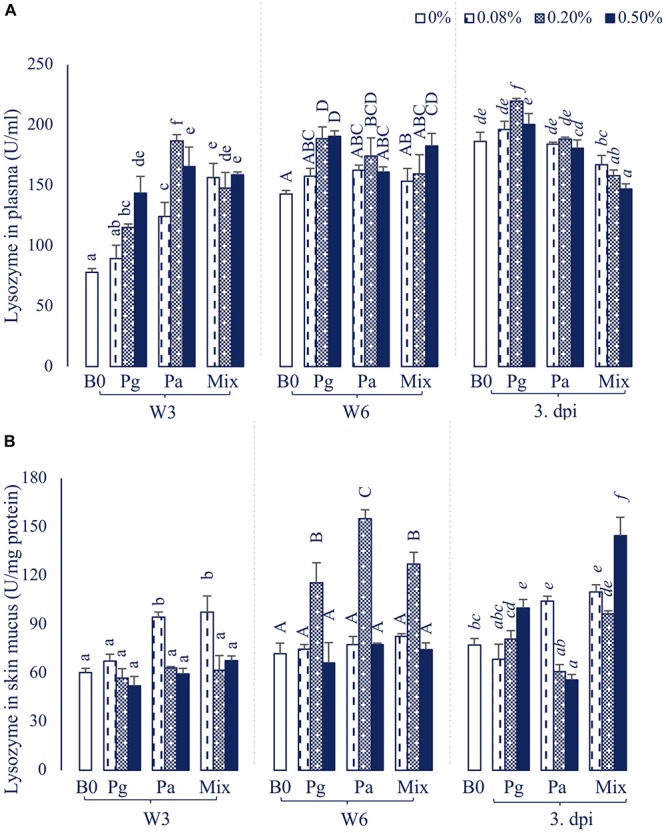
Lysozyme activity in (A) plasma and (B) skin mucus of striped catfish fed extract-based diets supplemented with a single supply or a mixture of P. guajava and P. amarus at 0; 0.08; 0.2; and 0.5% after 3, 6 weeks and 3 dpi. B0, basal diet; Pg, P. guajava; Pa, P. amarus; Mix, Mixture of P. guajava and P. amarus; W3, week 3; W6, week 6; 3 dpi, 3 days post injection with E. ictaluri. Different letters indicate differences among diets at a given time point (p < 0.05). Values are means ± SEM, n = 3.